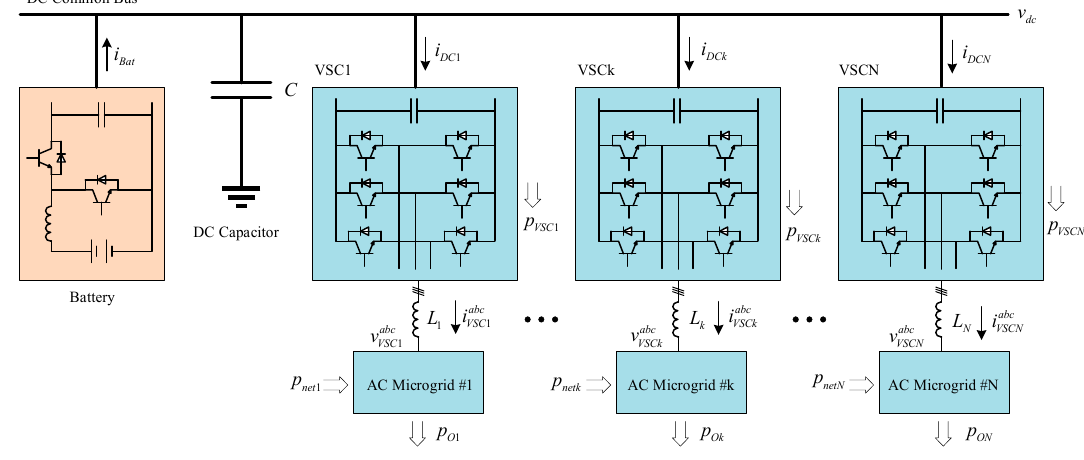
Figure 3. Power converter topologies of the multi-microgrid interconnection scheme.